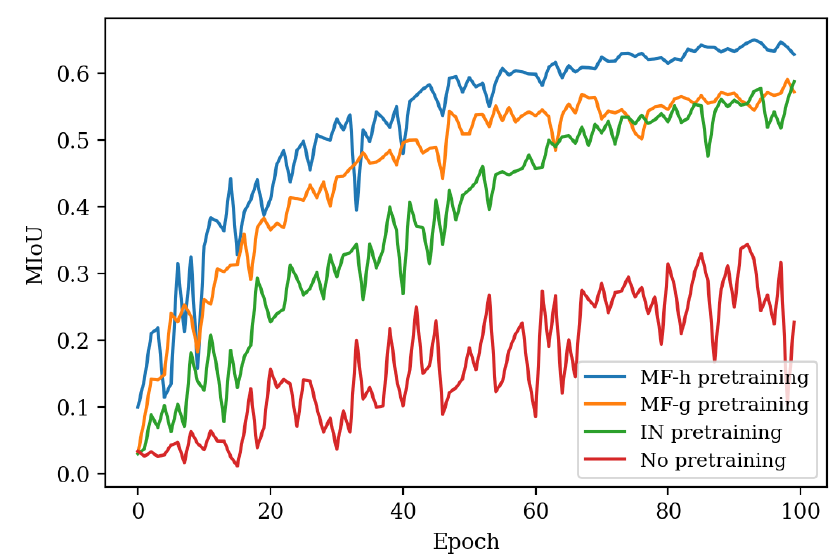
Figure 9. Mean intersection over union (mIoU) of the 2015 validation set (CycleGAN translated) during training when using no pretraining, ImageNet (IN) pretraining, MiniFrance (MF) greyscale (-g) or historical-like (-h, CycleGAN translated) pretraining.